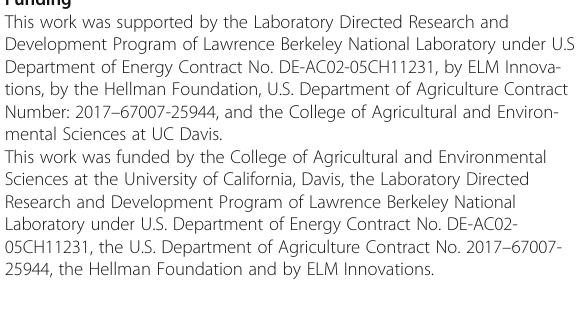
Coordinate Analysis plot. Table S3. OTU table. Table S4. Raw sequence barcodes for archived 16S rRNA gene amplicon data. Table S5. Results of AMOVA and HOMOVA statistical tests. (XLSX 3751